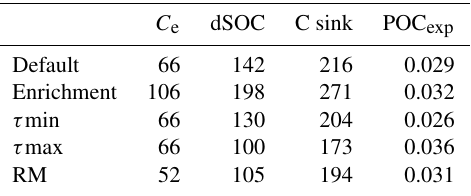
Table 7. Sensitivity analysis. The impacts of enrichment, changes to the sediment residence time ( τ min ,τ max), and crop residue man- agement (RM) on the cumulative gross C erosion ( C e ) , the cumula- tive change in the total SOC stock (dSOC), the net C sink, and the cumulative particulate organic C export flux (POC exp ) of the Rhine catchment (units: TgC). C